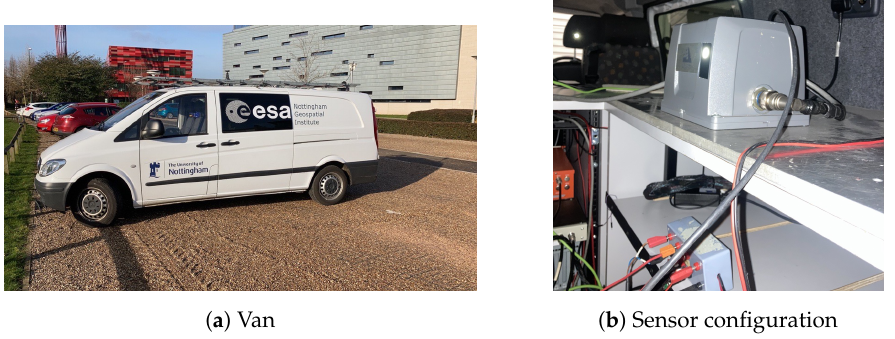
Figure 2. NGI test van.